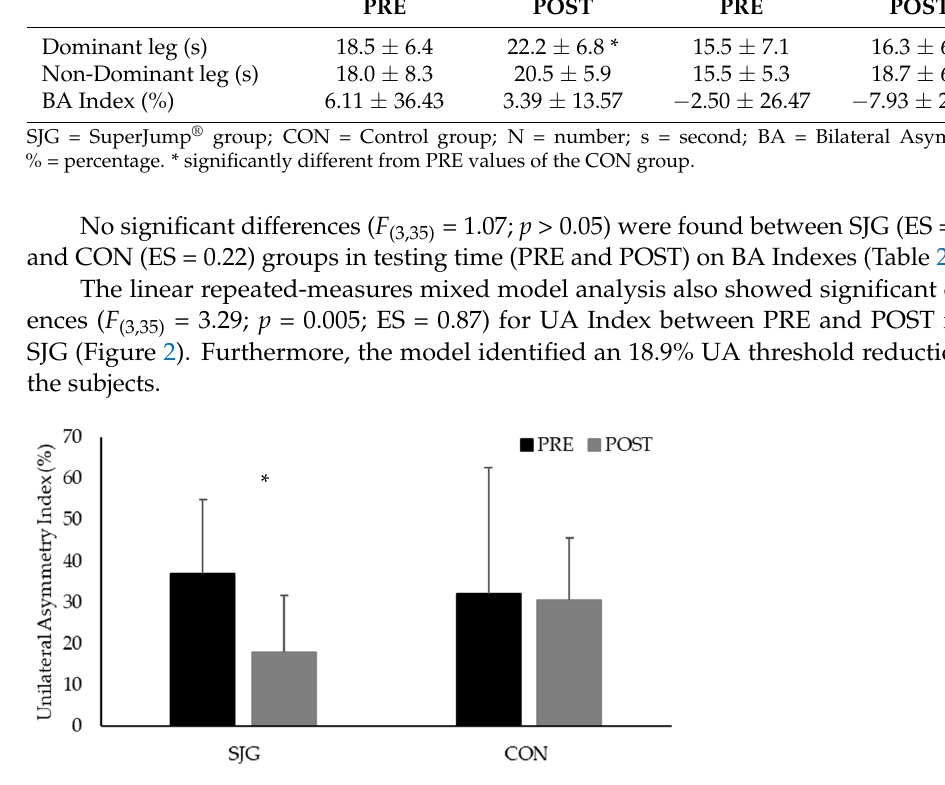
Figure 4. Means and standard deviations of Unilateral Asymmetry Index between the Bilateral Asymmetry equal and change categories. 4. Discussion This study aimed to investigate the effects of the SJ training on subject’s dynamic balance performance and to observe BA and UA Indexes acute changes after the SJ training intervention in healthy young adults. The relevant findings of the present study suggested that SJ training positively affected the UA Index for the SJG, by significantly reducing the lower limb balance asymmetry. Furthermore, considering the relationship between the UA Index ∆ change and UA Index baseline values, results showed that subjects with higher UA Index baseline values had higher UA Index ∆ change after the SJ intervention. On the other hand, a marginal and not significant effect of the SJ on BA Index was found. Plyometric training, such as repetitive jumps, represents a dynamic form of resistance training that involves displacements of the center of gravity resulting in improved dynamic postural control [28,29]. Thus, SJ training preserves both the characteristics of the stretching–shortening cycle and the displacements of the center of gravity, which characterize any type of plyometric training. It has been shown that plyometric training had chronic effects on the dynamic balance of young athletes in